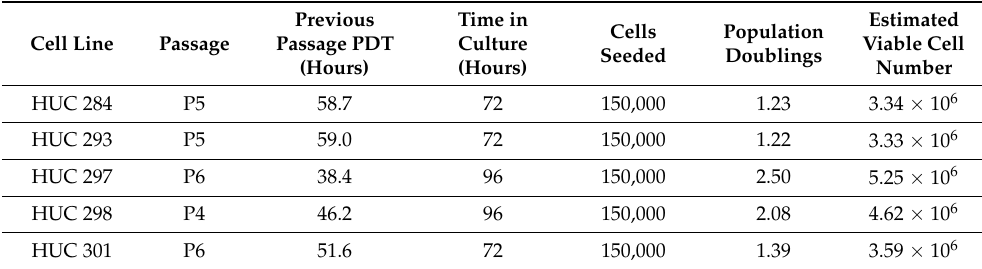
Table 4. Calculation of Viable Cell